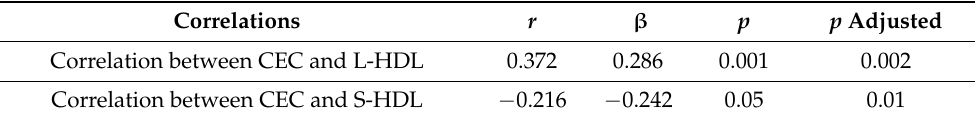
Table 2. Multiple linear regression for correlations between CEC and L-HDL or S-HDL subclasses. Correlations r β p p Adjusted Correlation between CEC and L-HDL 0.372 0.286 0.001 0.002 Correlation between CEC and S-HDL − 0.216 − 0.242 0.05